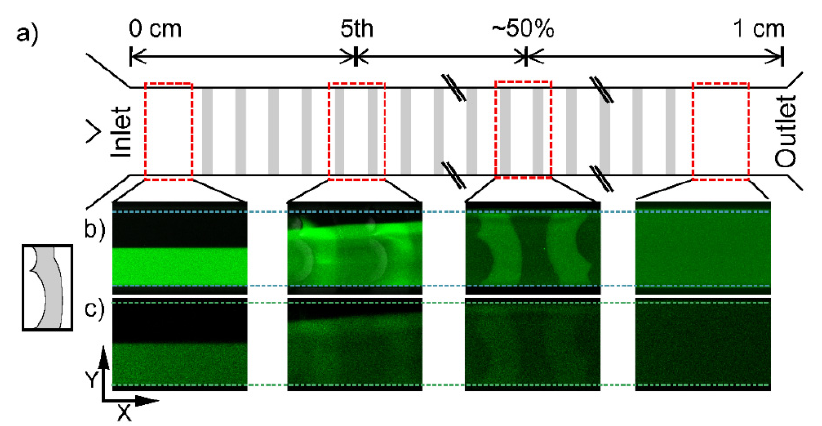
Figure A1. Schematic illustration of a mixing channel with arbitrary mixers (black dashed rectan- gles) for location purposes from the inlet (left) to the outlet (right). ( a ) Schematic illustration of a microfluidic mixing channel containing DCMS.Confocal XY view averaged intensity for ( b ) all Z levels and ( c ) the sensor layer. XYZT-stacks were acquired after each structure until the 10th structure, subsequent stacks were recorded after each structure. For mixing channels with fewer than 50 structures, stacks were recorded after every fifth structure.